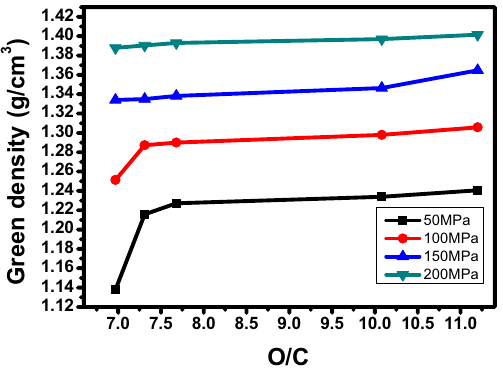
Figure 3. Green density change due to O/C change at constant molding pressure.